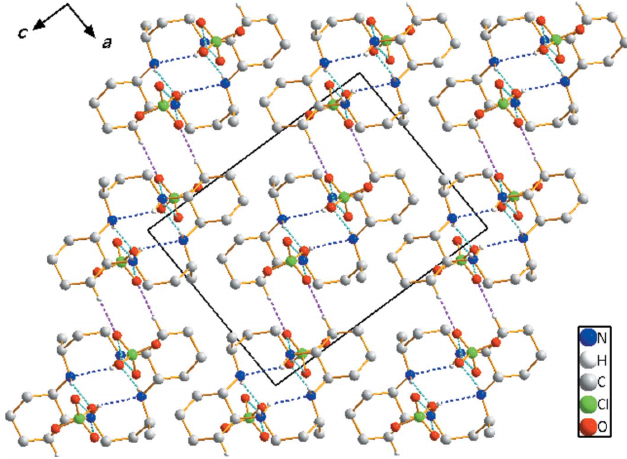
Figure 2 Crystal packing in compound (I), viewed perpendicular to the ac plane. Dashed lines represent N—H (cid:2)(cid:2)(cid:2) O (cyan), N—H (cid:2)(cid:2)(cid:2) N (blue) and C— H (cid:2)(cid:2)(cid:2) O (purple) hydrogen-bonding interactions, respectively.